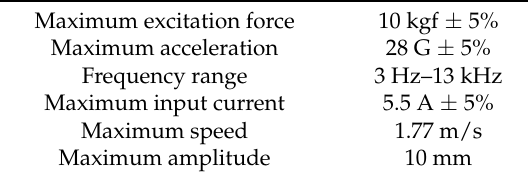
Figure 6. Photograph of the vibrator. Table 4. Specifications of the vibrator.